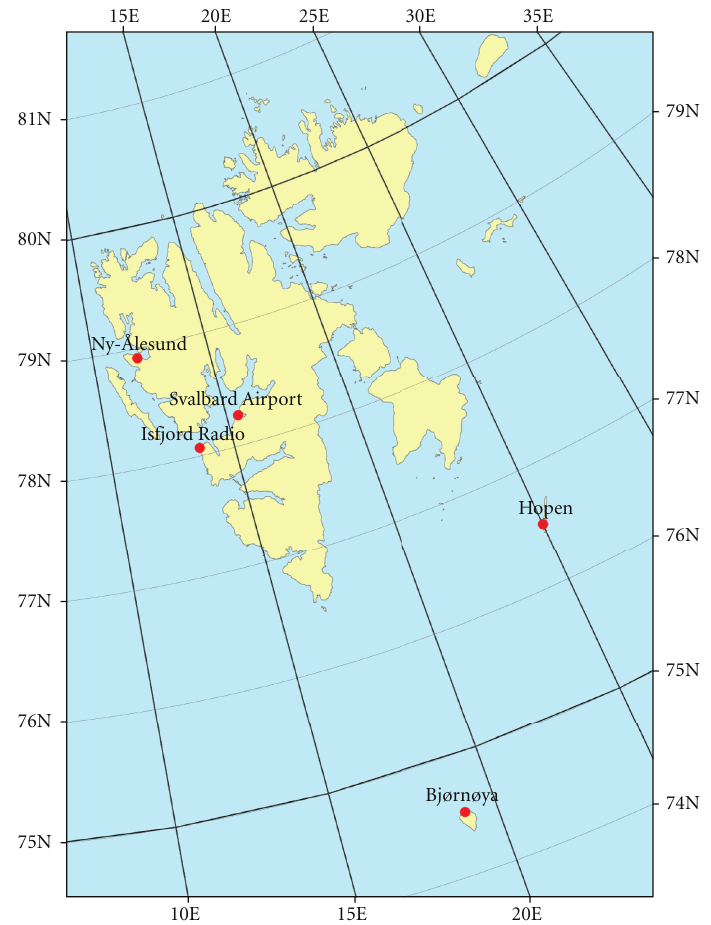
Figure 1: Map of the Svalbard region including weather stations used in the analysis.